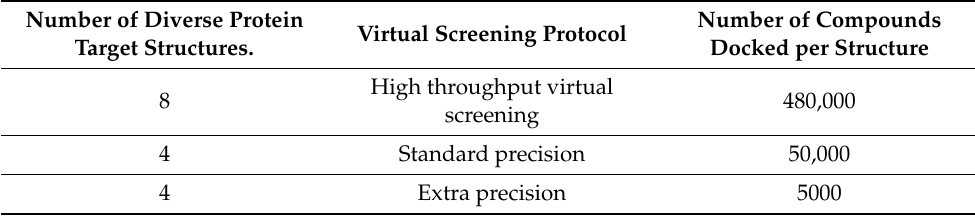
Table 5. Virtual screening strategy. Number of Diverse